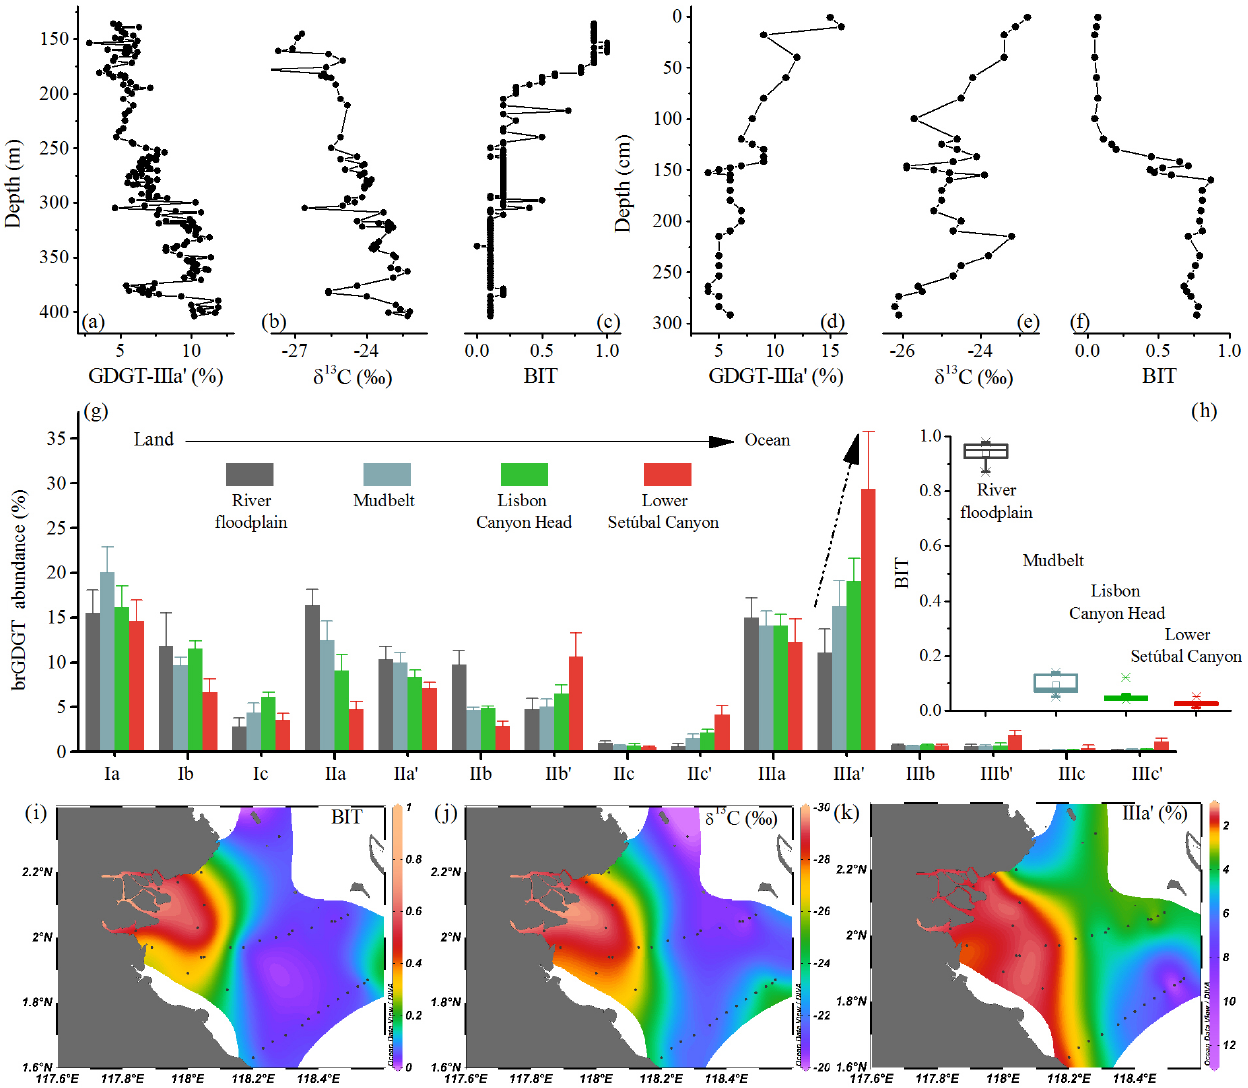
Figure 7. Vertical profiles of (a) the proportion of GDGT IIIa (cid:48) , (b) δ 13 C OC , and (c) BIT index of a marine sediment core from the North Sea Basin (Dearing Crampton-Flood et al., 2018). Vertical profiles of (d) the proportion of GDGT IIIa (cid:48) , (e) δ 13 C OC , and (f) BIT index of a marine sediment core from the Kara Sea (De Jonge et al., 2016). Spatial distribution patterns of (g) average distribution of brGDGTs and (h) BIT index in the transect from the land to the ocean off the Portuguese coast (river floodplain, mudbelt, Lisbon canyon head, and lower Setúbal canyon) (Warden et al., 2016). Isosurface plots of (i) BIT index, (j) δ 13 C OC , and (k) the proportion of GDGT IIIa (cid:48) of the surface sediments from the Berau River delta (Sinninghe Damsté,